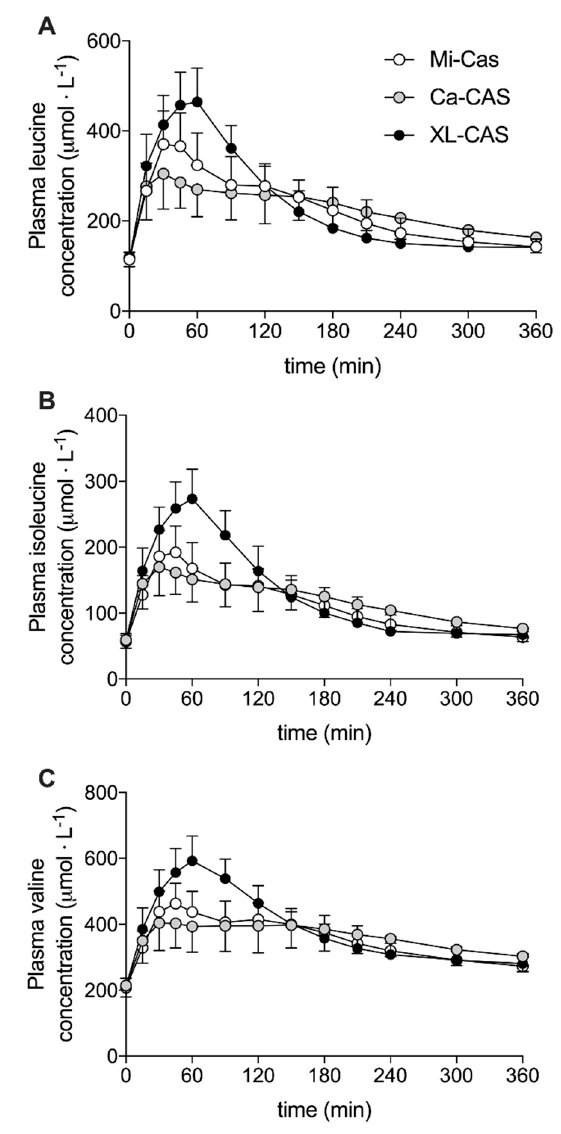
Figure 3. Plasma branched-chain amino acids concentrations: leucine ( A ), isoleucine ( B ), and valine ( C ). Means ± SD ( n = 15). Ca-CAS: caseinate protein; XL-CAS: cross-linked casein protein; Mi-CAS: micellar casein protein.